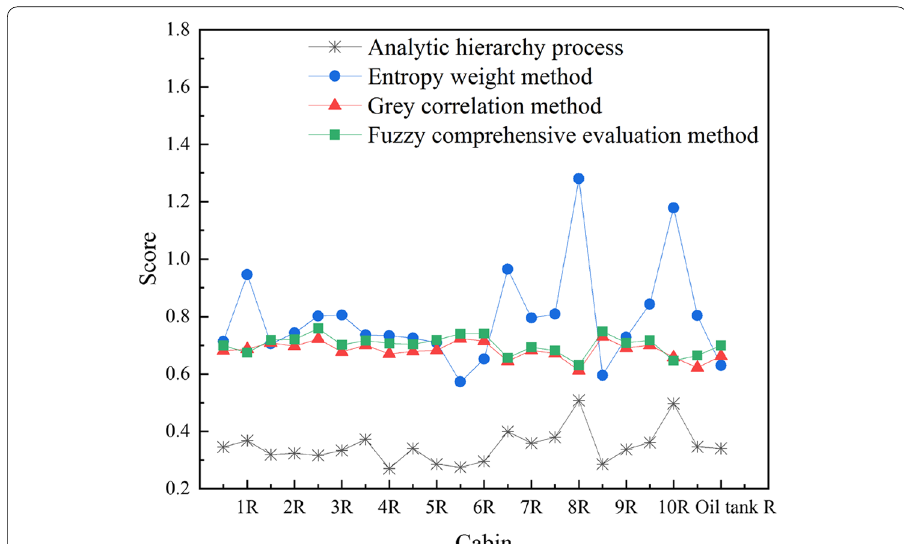
Fig. 4 Comparison of evaluation results of different models